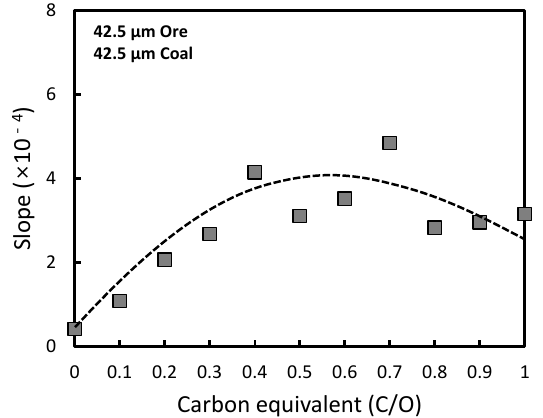
Figure 10. Relationship between effective diffusion coefficient and carbon equivalent.